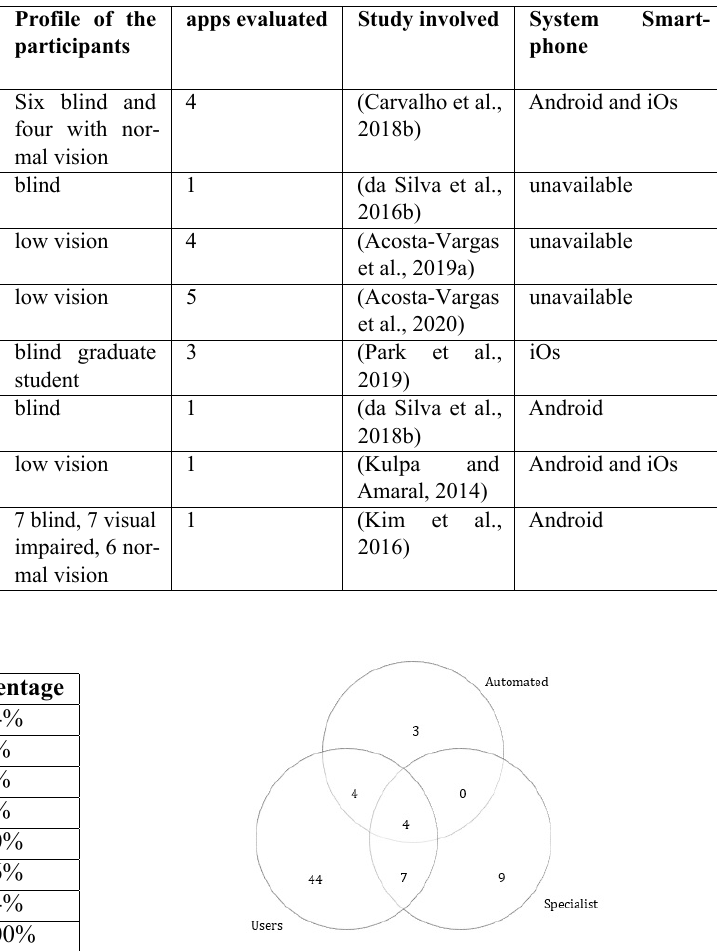
Table 7. Characteristics of user evaluations on mobile apps.